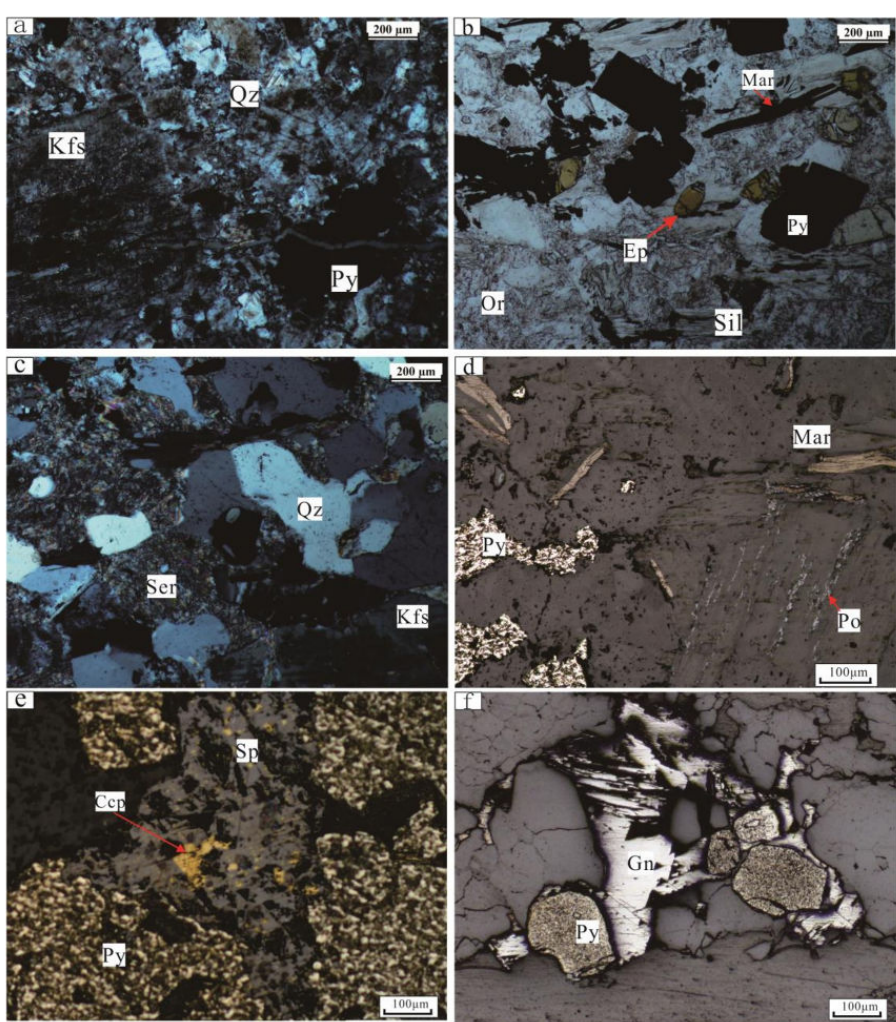
Figure 7. Optical microscope photographs showing mineral assemblages. ( a ) and ( b ) The area of K-feldspar alteration under plane polarized light, respectively ( c ) the area of early silicification alteration under plane polarized light, respectively. Quartz fragments exhibit irregular shapes with sericite. ( d ), ( e ), ( f ) show the main metal mineral assemblages under reflected light. Kfs: K-feldspar; Py: pyrite; Qz: quartz; Or: orthoclase Ep: epidote; Sil: sillimanite Mar: marcasite; Ser: sericite; Po: pyrrhotite; Ccp: chalcopyrite; Sp: sphalerite; Gn: